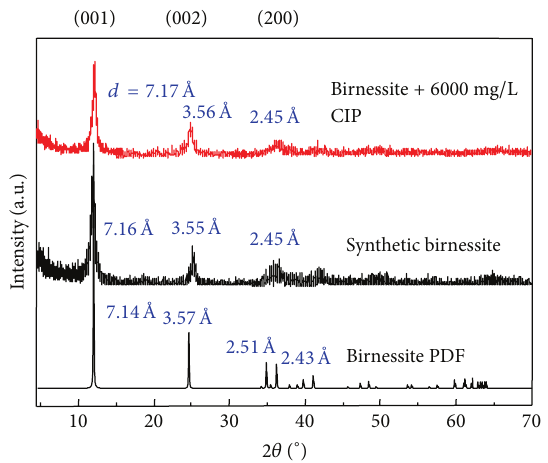
Figure 2: X-ray diffraction patterns of birnessite (V) and birnessite (V) which was reacted with the concentration of 6000 mg/L CIP solution.